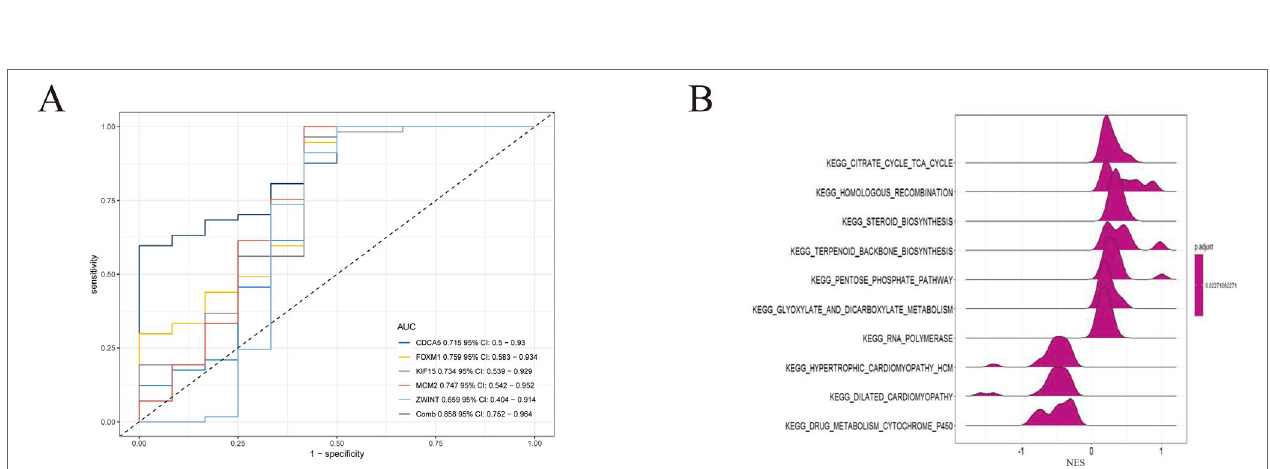
FIgUrE 14 | (A) Receiver operating characteristic (ROC) curve analysis and area under the curve (AUC) statistics were implemented on different databases to evaluate the capacity of key genes to distinguish EOC and normal tissues. (B) GSEA was applied to obtain biological process enriched in five key genes with highly expressed